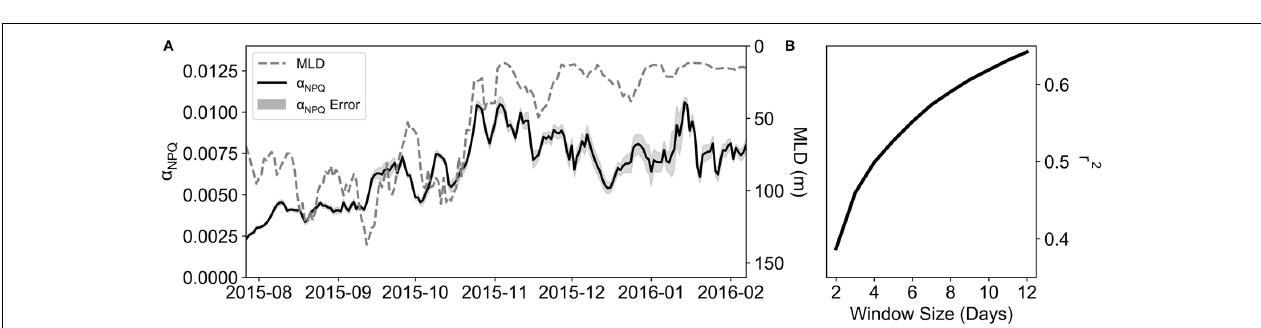
FIGURE 5 | Example depth profiles from glider dives on 13/08/2015 (winter) and 05/01/2016 (summer) of (A) NPQ Glider and (B) PAR ( µ mol photons m - 2 s - 1 ). (C) Example NPQ Glider versus PAR curves for both winter and